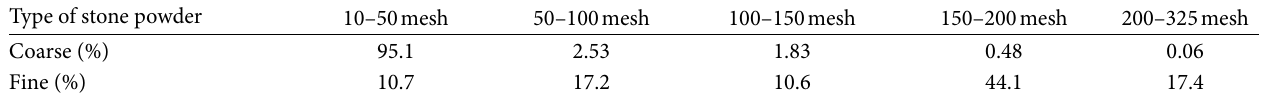
3: Screening table for stone powder